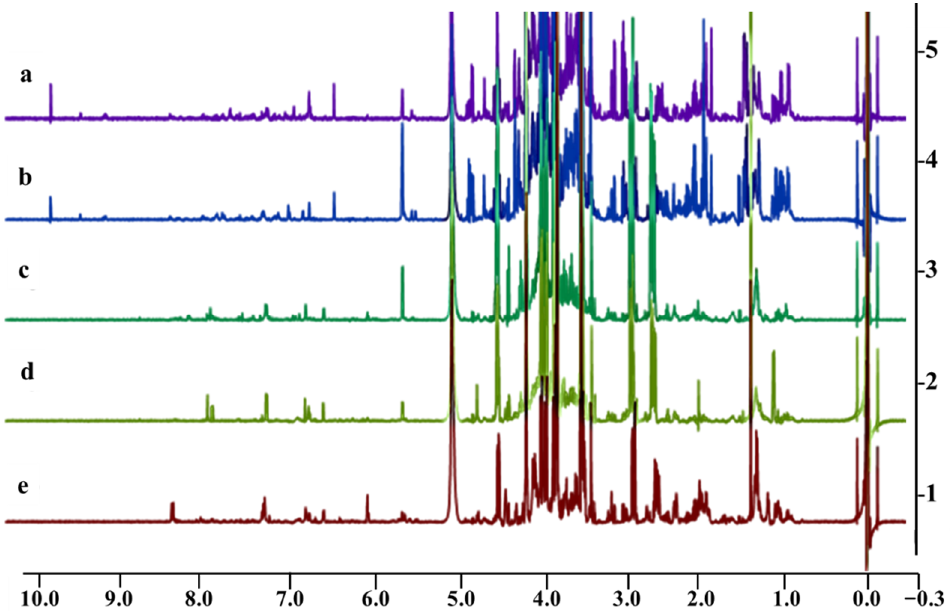
Figure 3. Stacked 1 H NMR spectra of leaves’ extracts of ( a ) V. sieberiana, ( b ) V. tortilis, ( c ) V. kosiensis, ( d ) V. xanthophloea and ( e ) V. karroo .